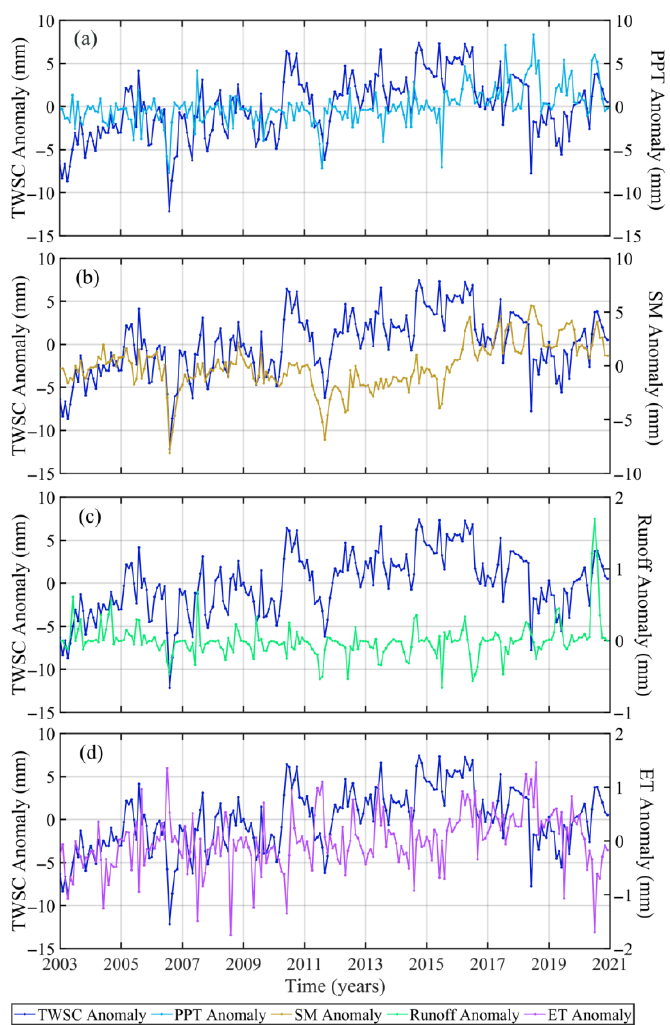
Figure 6. The time series of TWSC and four hydrometeorological factor anomaly (( a ), PPT; ( b ), SM; ( c ), runoff; ( d ), ET) during 2003~2020 in the UY. Table 3. The correlation coefficients between TWSC, PPT, SM, ET, and runoff anomaly in the UY (these results have passed the 95% confidence level).